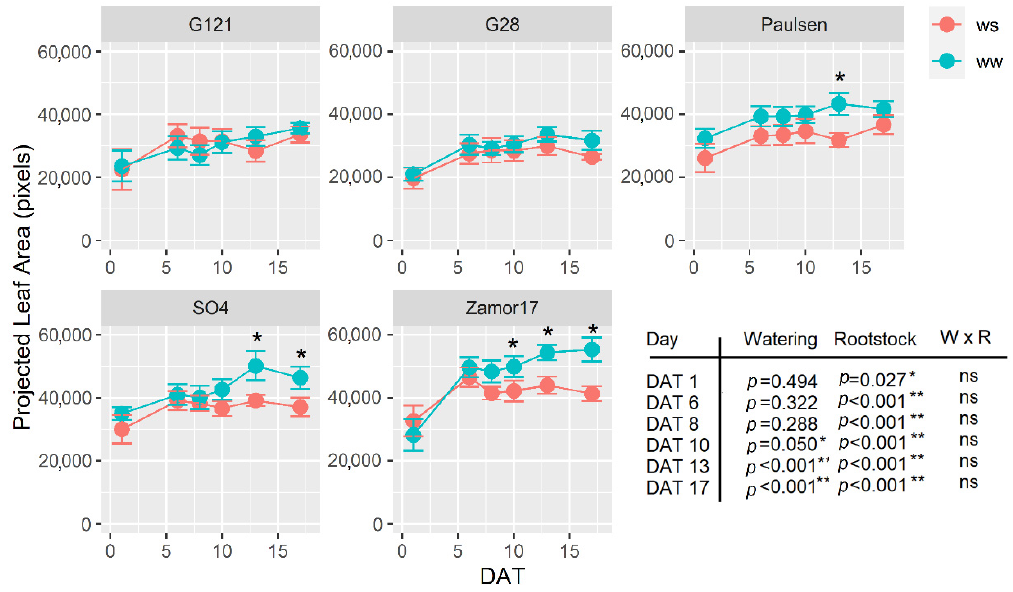
Figure 5. PLA for Pinot gris grafted on different rootstocks collected over the experimental period and for plants subjected to well-watered (WW) and water-stressed conditions (WS). Asterisks represent significant differences between WW and WS for each rootstock. The p -value from two-way ANOVA is shown for each DAT and factor while ns represent non-significant differences. Data shown are means ± standard error of the means (SEM, n = 6–9).